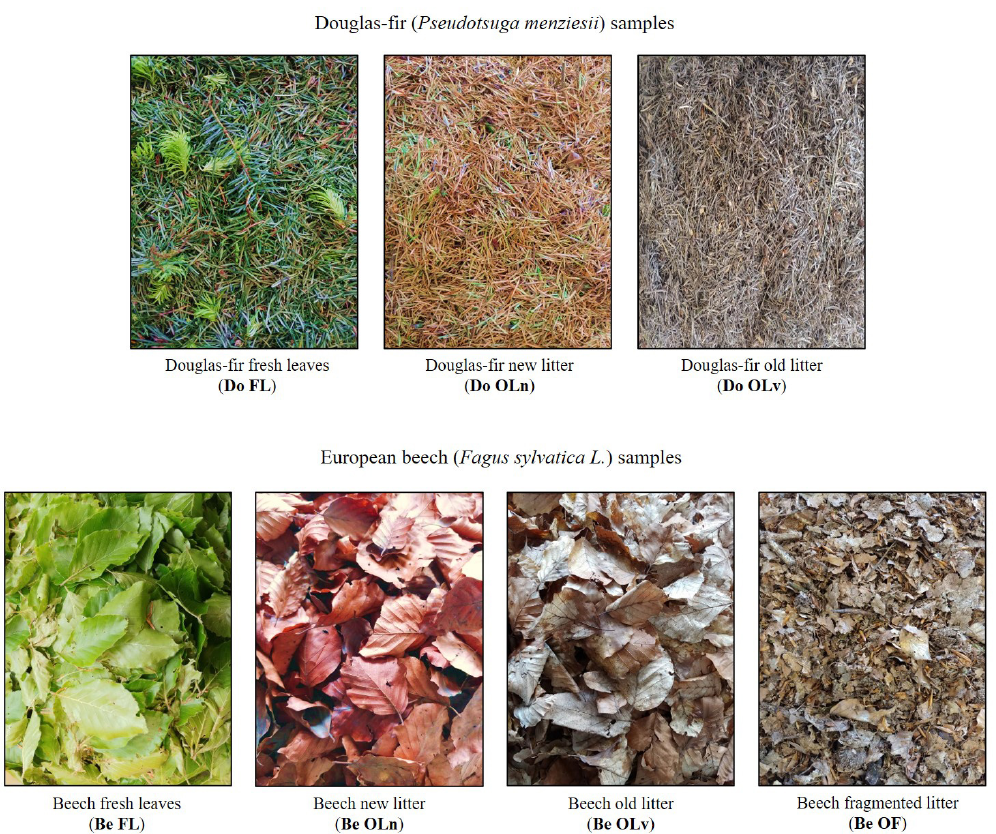
Figure 1. Fresh leaves and litter of European beech and Douglas-fir collected at the Weierbach experimental catchment and sorted by degradation